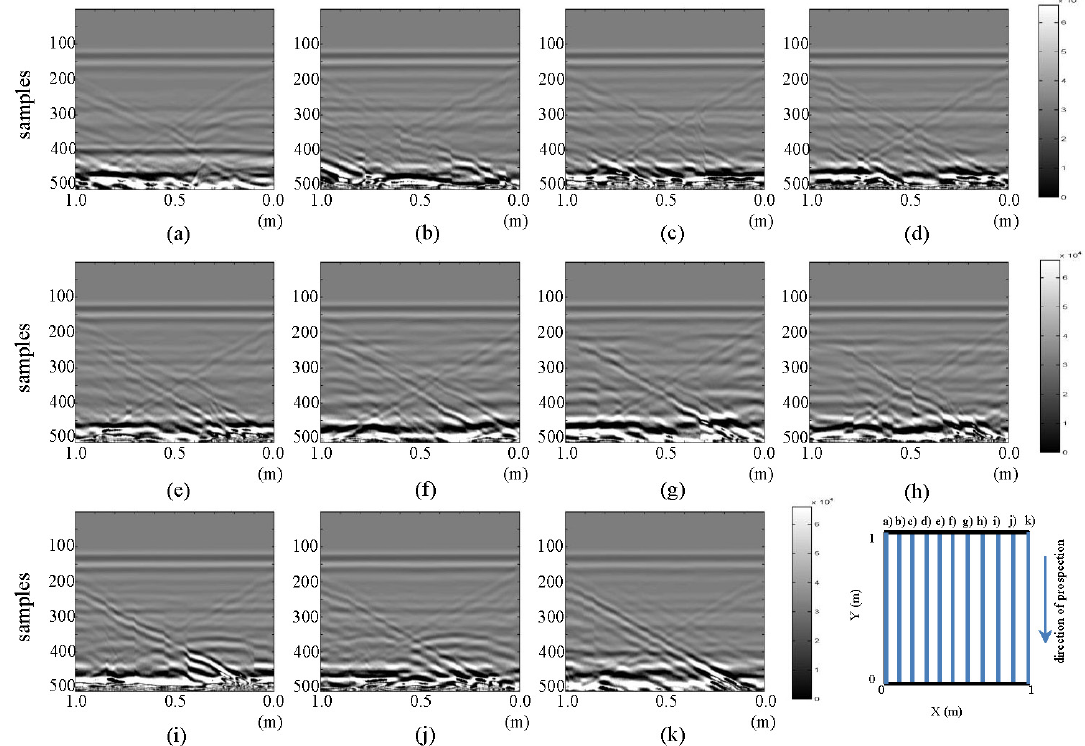
Figure 6. Vertical profiles: raw images for final state: ( a – k ) are profiles s12 to s22,